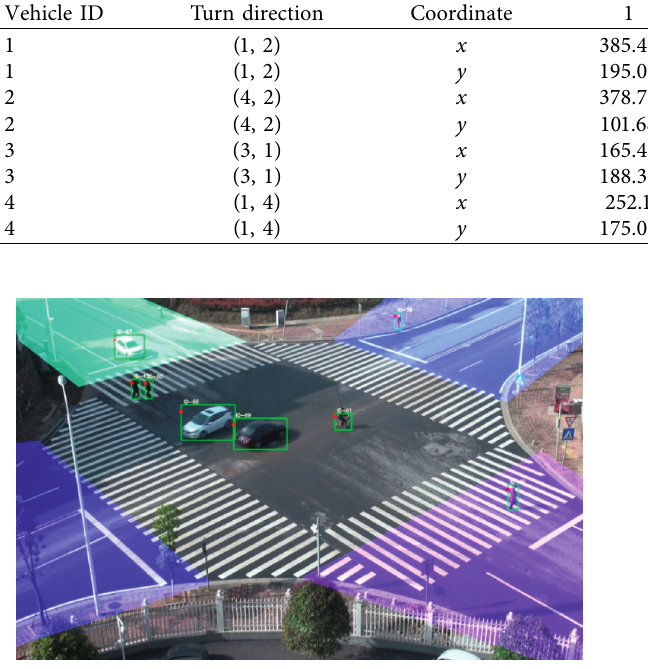
Figure 6: Recognition area of the entrance and exit of the intersection.